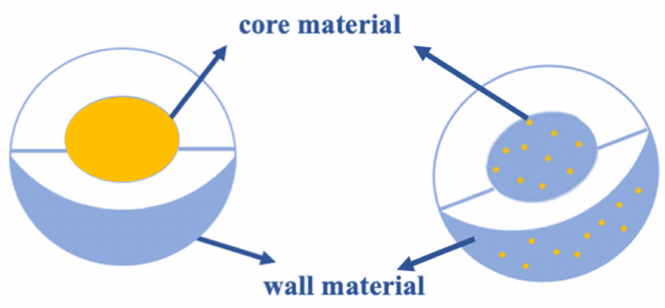
Figure 1. Morphology of microstructures.